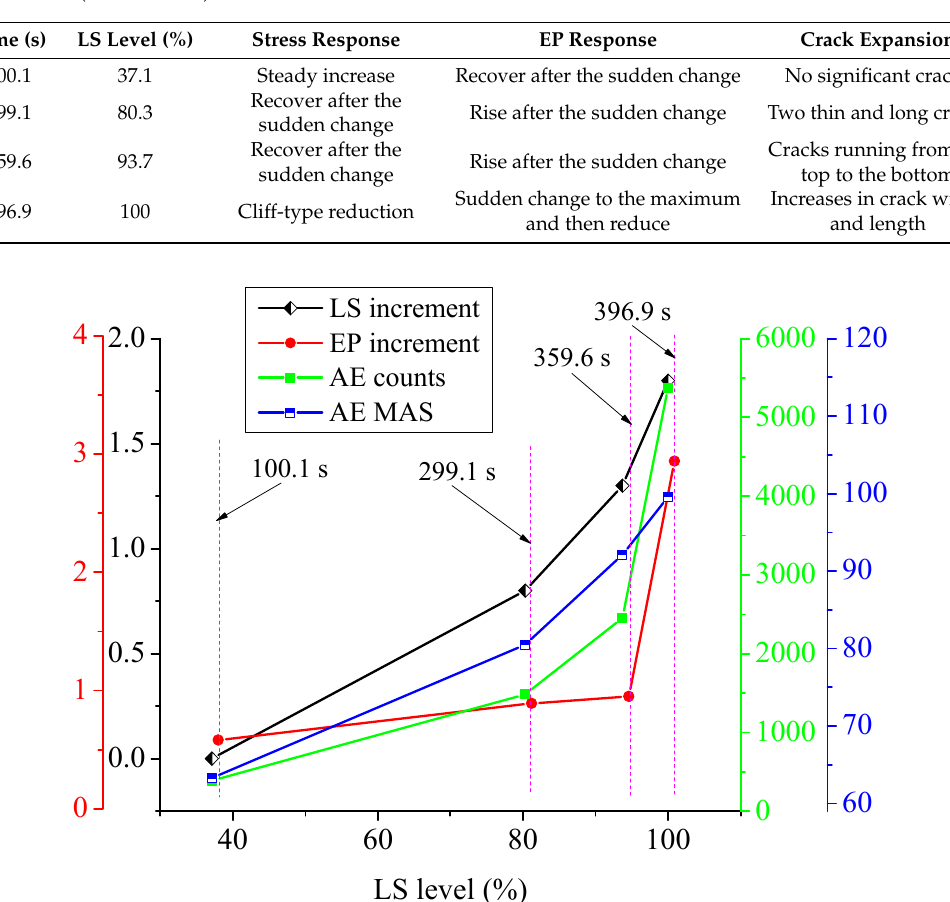
Table 2. Statistics on characteristics of EP, AE and crack expansion under different loading time